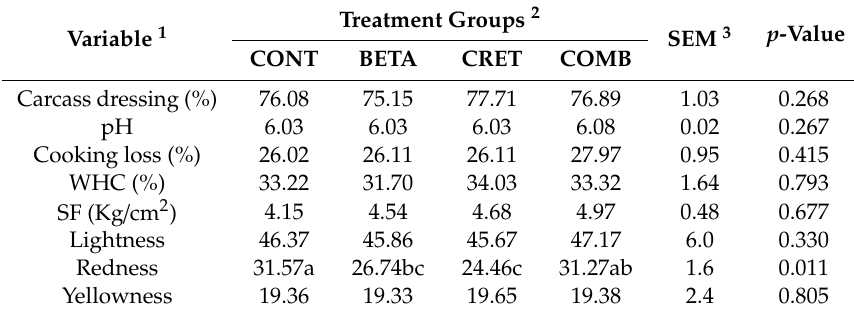
Table 3. Means of carcass dressing (%), pH, breast meat cooking loss (%), water holding capacity (WHC, %), shear force (SF) Kg / cm 2 , and breast meat color values of broiler chicks fed dietary betaine (B) and / or creatine